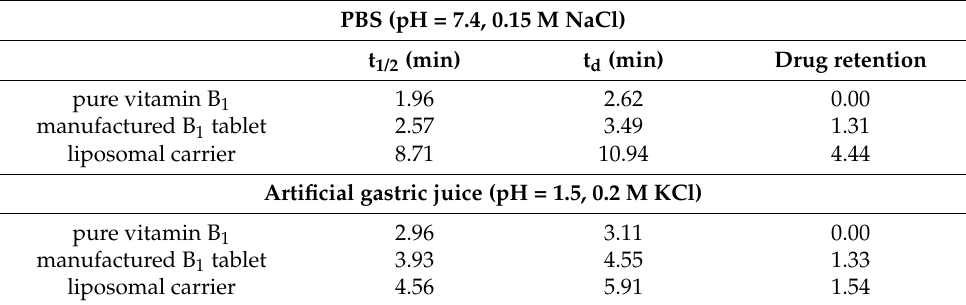
Table 1. The half-life (t 1/2 ) and the drug retention values determined by second-order kinetic models for different